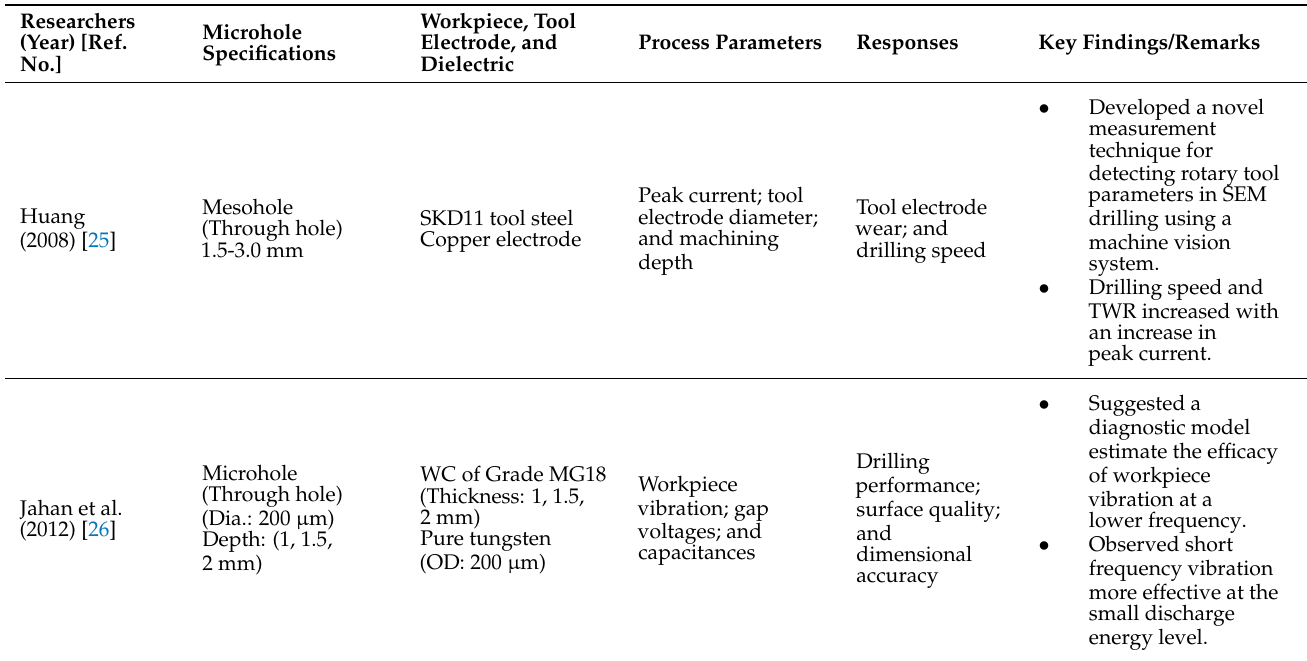
Table A1. Summary of the previous research on fabrication of high precision deep fine holes by SEM, µ -SEM, SED, and µ -SED